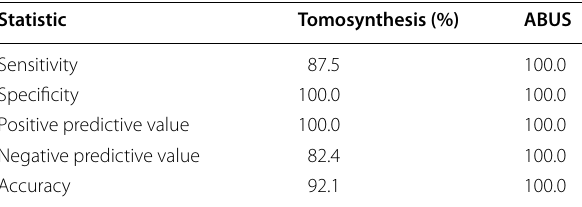
Table 9 Comparison between accuracy measures of ABUS